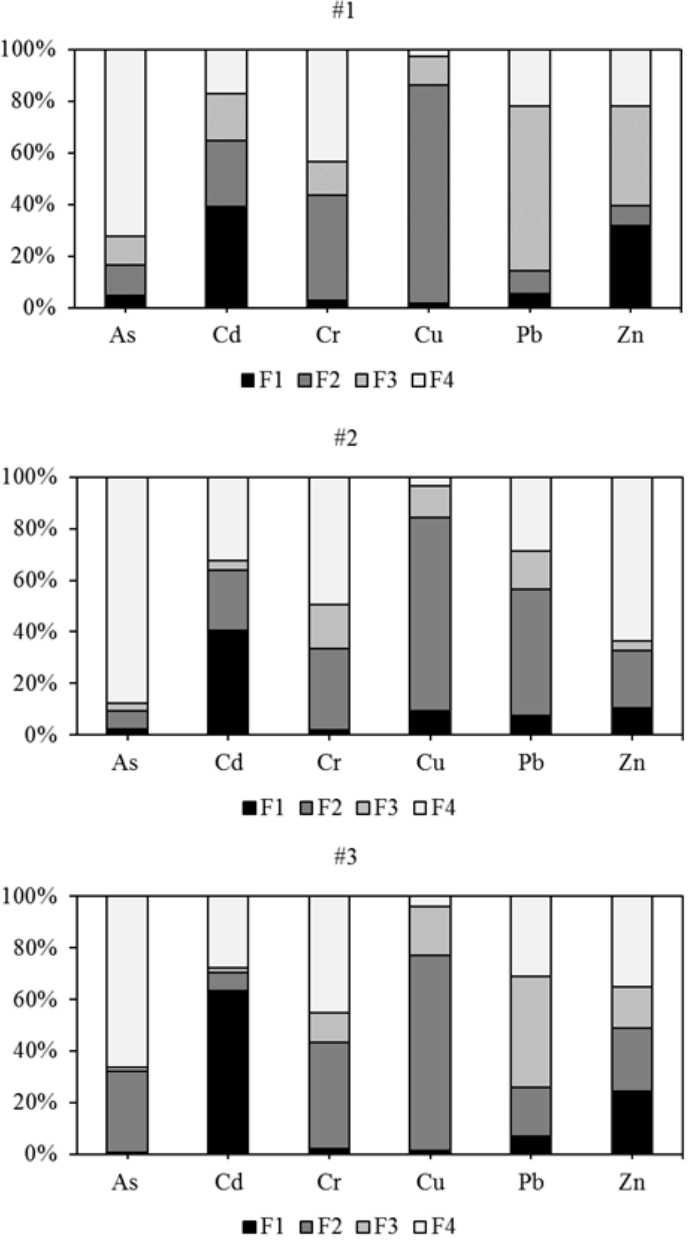
Figure 2. The speciation distributions of PTEs in top soils from three sites in North China. (F1, water/acid-soluble fraction; F2, reducible fraction; F3, oxidizable fraction; F4, residual fraction; Total, total metal concentration. The sample sites are: #1, #2, and #3).